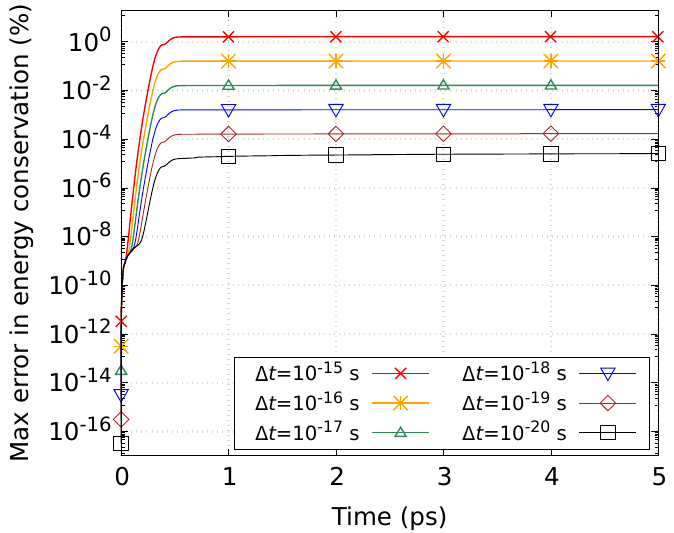
Figure 3. Maximal relative error in energy conservation as a function of simulation time for six different time steps. The quantity is calculated from the difference between total absorbed fluence and the total energy in the system.